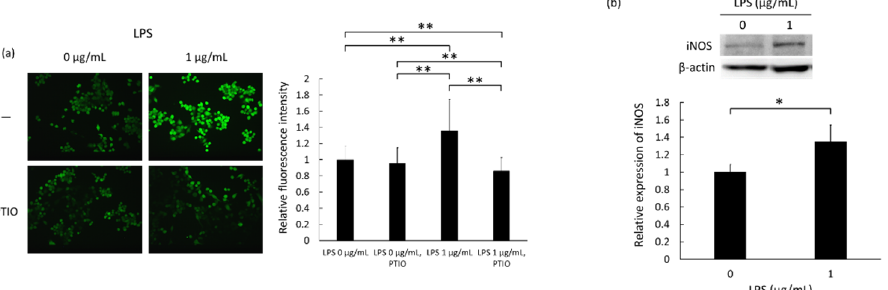
Figure 1. Intracellular nitric oxide (NO) and inducible NO synthase (iNOS) levels in RAW264 macrophages following treatment with 0 or 1 µg/mL lipopolysaccharide (LPS) for 24 h. ( a ) Intracellular NO production was assessed using the fluorescence probe diaminofluorescein-FM diacetate (DAF-FM DA). Carboxy-PTIO was used for NO scavenging. Statistical significance was assessed using Scheffe’s test. Data are shown as mean ± standard deviation. ** p < 0.01. ( b ) Expression of iNOS assessed by Western blotting. Statistical significance was determined using Student’s t -test. Data are shown as mean ± standard deviation; n = 3. * p < 0.05.